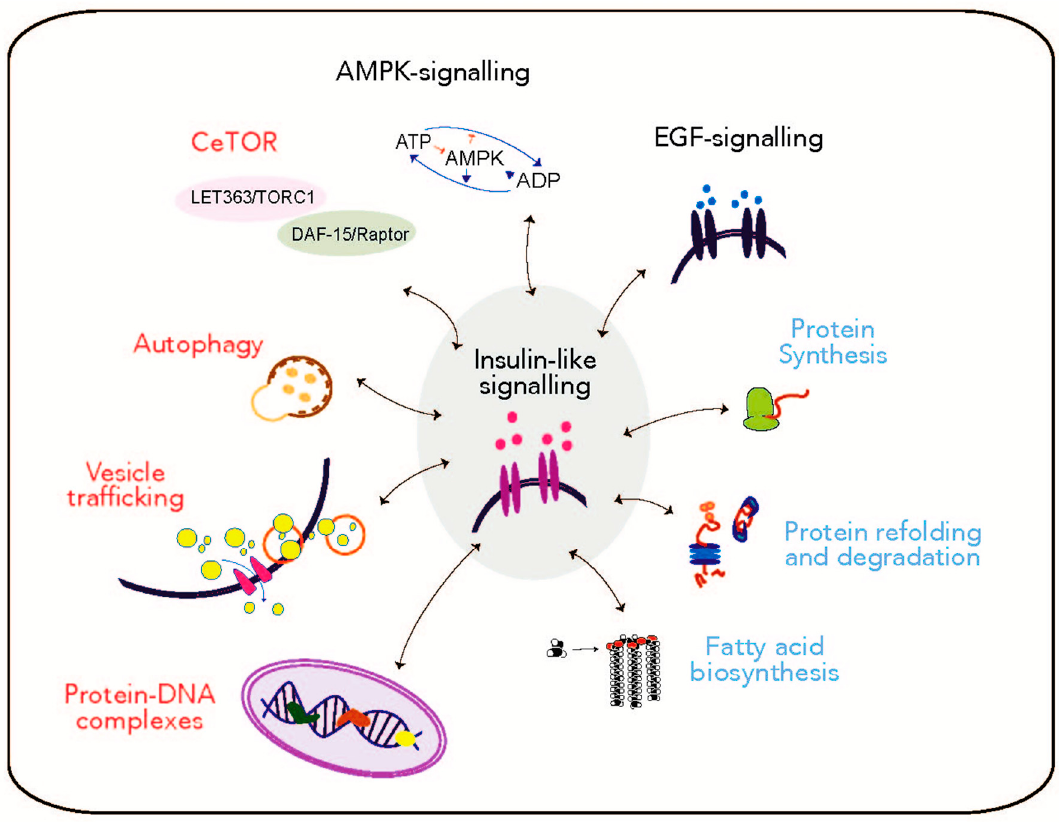
Figure 2. Map of differentially-regulated pathways in response to persistent DNA damage in nucleotide-excision repair (NER) deficient animals. Insulin-like signalling comprises a central node of a DNA damage response network, which involves the regulation of the epidermal growth factor (EGF)-, and AMP-activated protein kinase (AMPK)-like signalling pathways. The impaired proteostasis can lead to a general decrease in energy level, as exemplified by the attenuated fatty acid metabolism, and can be compensated by a shift towards autophagy. The processes that are downregulated or upregulated upon unrepaired DNA lesions are depicted in blue and red, respectively. CeTOR: C. elegans target of rapamycin; DAF, abnormal dauer formation.